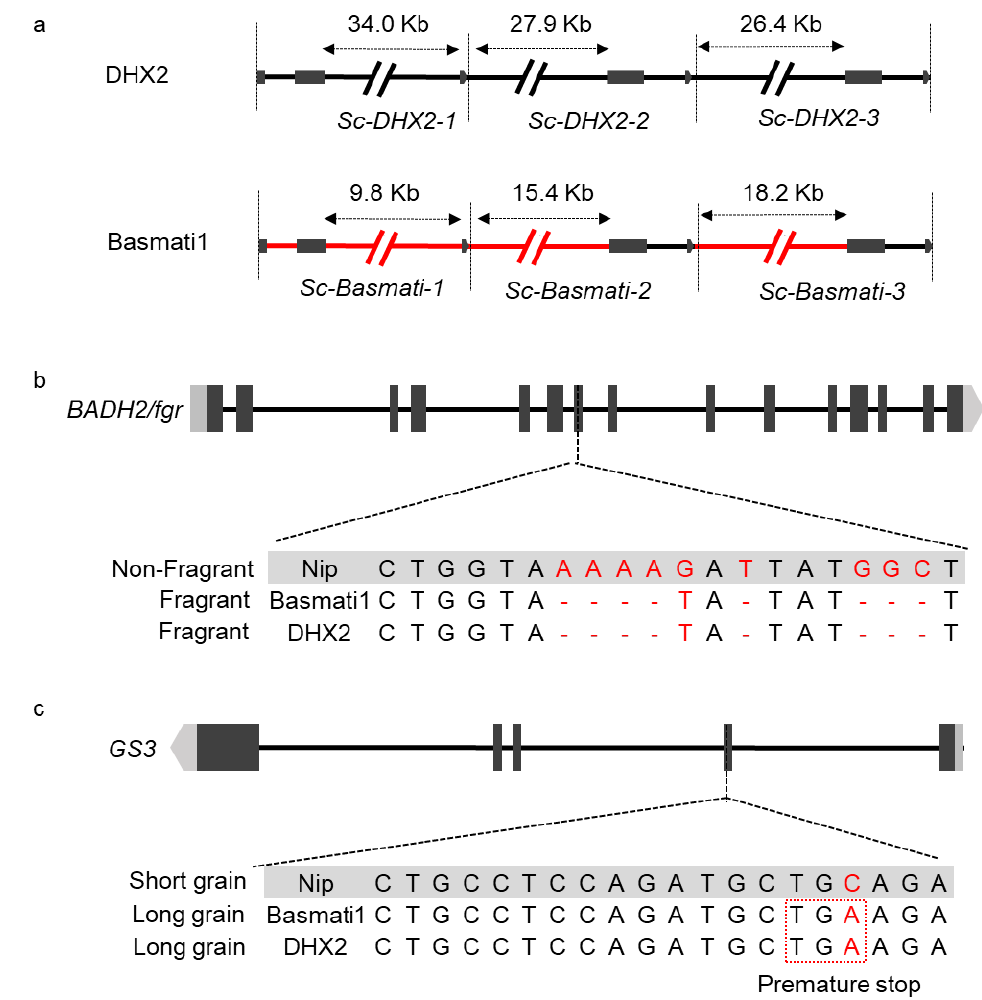
Figure 5. The introgression loci in DHX2 from Basmati1. ( a ) The structural variation of the Sc locus in DHX2 and Basmati1. The red line indicates that the sequence of Basmati1 is different from DHX2; ( b ) the sequence variation of BADH2 / fgr in DHX2, Nip, and Basmati1; ( c ) the sequence variation of the GS3 locus in DHX2, Nip, and Basmati1.